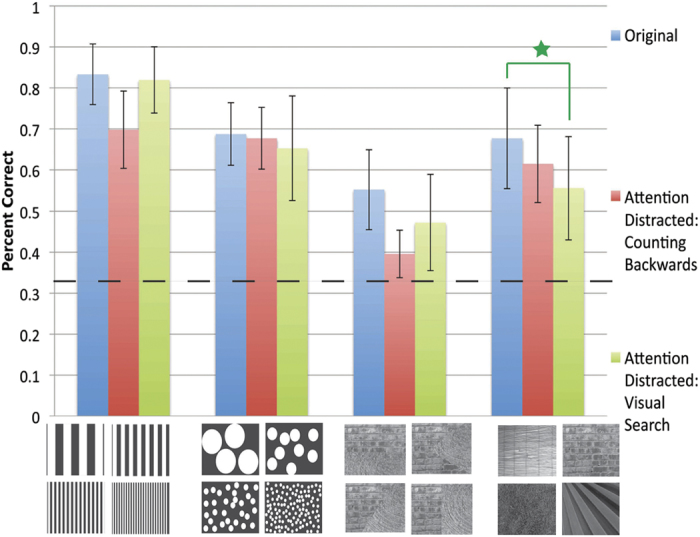
Data and images for matching sounds to images with and without distractors.The results for both visual (N = 6) and auditory (N = 8) distractor versions in comparison to the original vOICe bimodal matching experiment are plotted in Fig. 5. The error bars represent the standard deviation across participants, and the dashed line represents chance. The star indicates that the distractor version is significantly different from the original mapping. Image sources2829 are referenced in the supplemental (Note: A few of images shown are images similar to the experimental images, as the original images are restricted by copyright, so all original images are also referenced in the supplemental and can be viewed here: http://neuro.caltech.edu/page/research/texture-images/). Note: Photo 23 courtesy of Morguefile.com, under the general Morguefile license (www.morguefile.com/license).